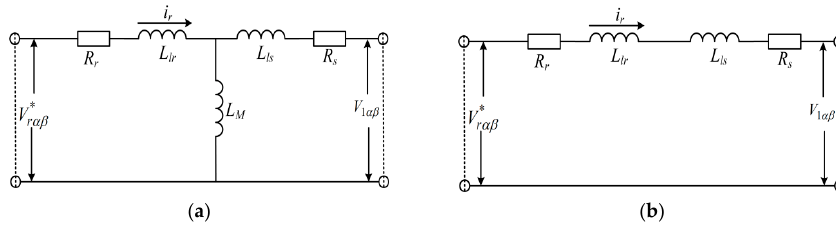
Figure 6. DFIG machine equivalent circuit ( a ) Overall; ( b ) simplified.